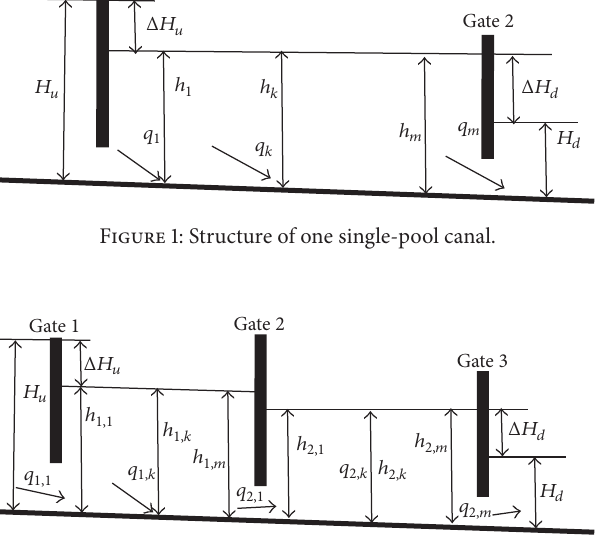
Figure 2: Structure of a two-pool cascaded